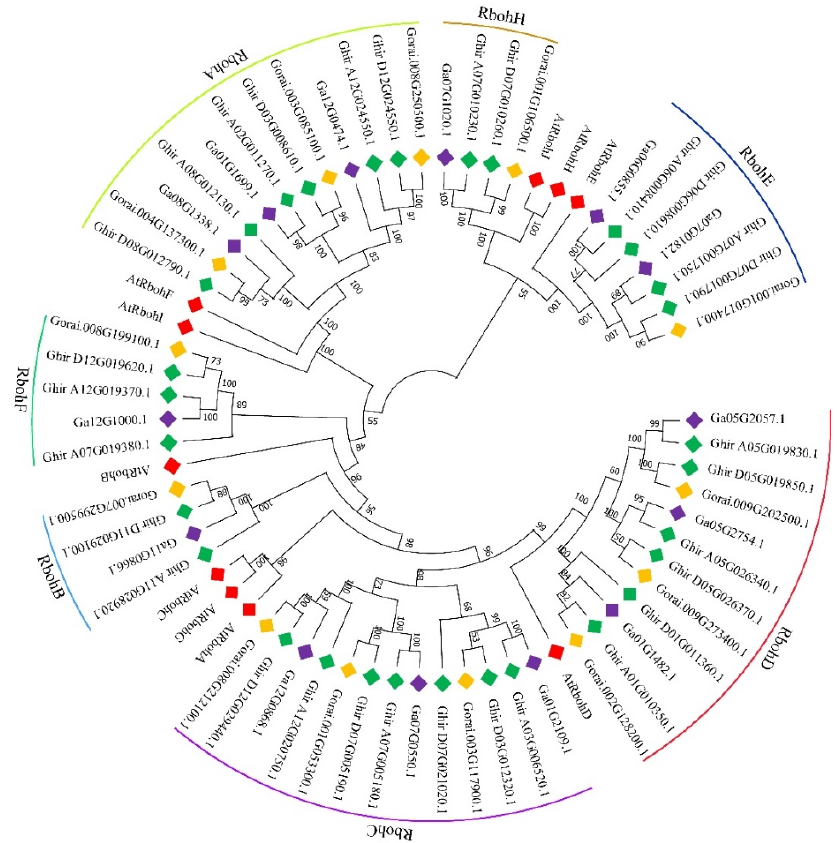
Figure 1. Phylogenetic analysis of Rbohs in Gossypium species. A phylogenetic tree of Rboh proteins from G. arboreum , G. raimondii , G. hirsutum and A. thaliana . The full-length amino acid sequence of Rbohs protein family was compared by ClustalX in MEGA7.0 using the neighbor-joining (NJ) method. Different colored solid squares indicate different genes of the genus Cotton or Arabidopsis .